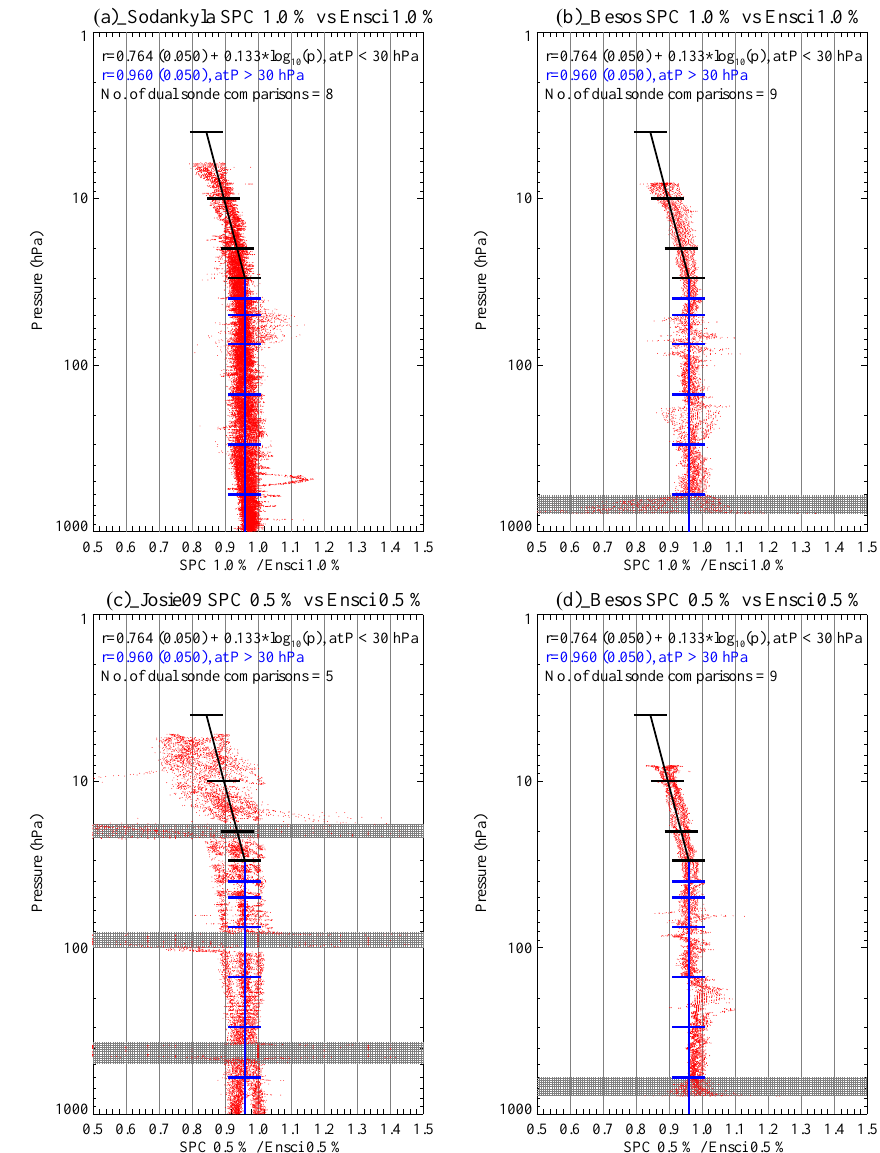
Figure 7. Vertical profiles of ratios of ozone partial pressure using ozonesondes of different manufacturer (SP, EN) with the same KI concentrations in both ozonesondes, either 1.0% (a, b) or 0.5% (c, d) . (a) Sodankylä – 1.0%; (b) BESOS – 1.0%; (c) JOSIE09 – 0.5%; (d) BESOS – 0.5%. The hashed areas denote regions of low ozone concentration in tests in the laboratory during JOSIE09, or during initial problems with the BESOS data system. Fits to the data using the transfer functions from Eq. (6), and included at the top of each panel, are shown in blue and black. The numbers in parentheses behind each slope are the uncertainties of the